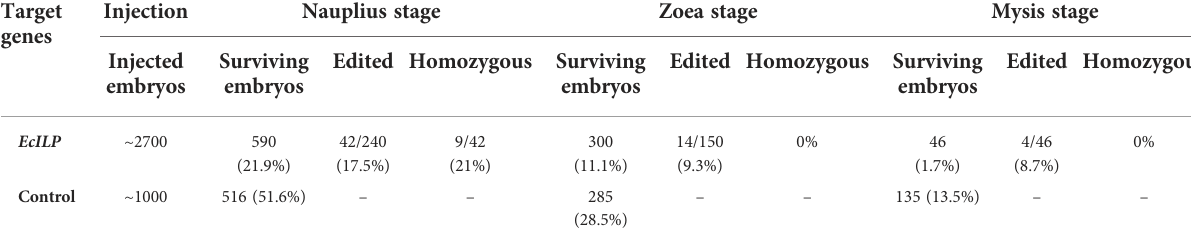
TABLE 2 Statistics on the survival and editing ef fi ciency after injection of CRISPR/Cas9